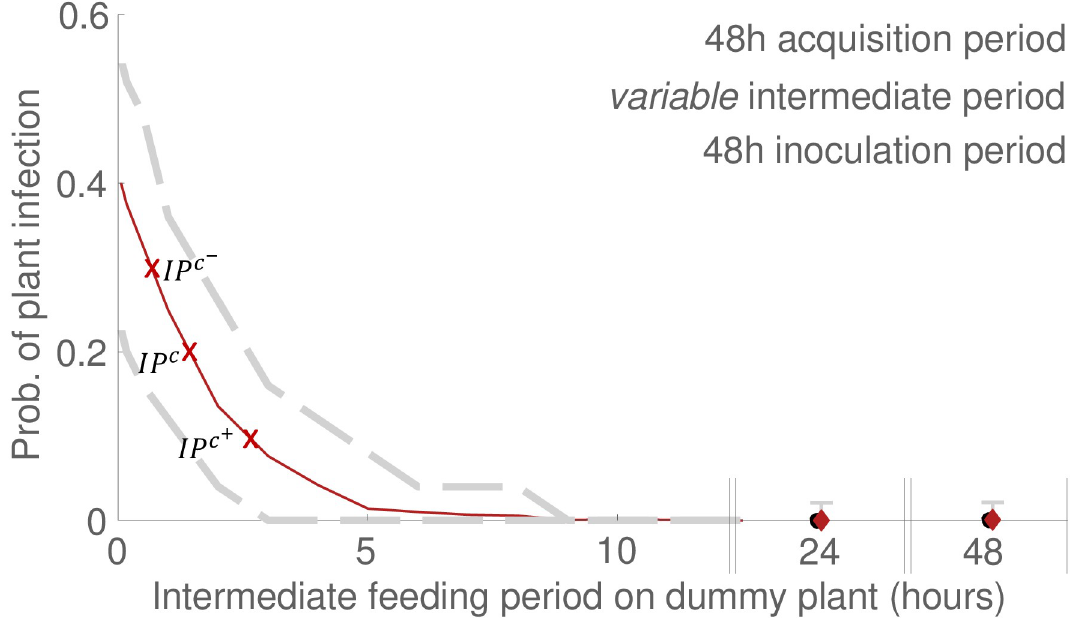
Fig 5. An empirical test of epidemiological parameter estimates for CBSV: Dynamic simulations vs. experimental data for variable intermediate feeding periods. An additional experiment is described in Maruthi et al . in which insects were given access to an intermediate feeding period on a dummy plant [1] (see methods section). Black circles indicate datapoints from [1]. Ruby curves/ diamonds indicate the mean of simulations. Gray dashed curves/gray intervals indicate the 2.5th and 97.5th percentiles of simulations. Red crosses mark the intermediate period at which transmission success was 50% of that of no intermediate period ( IP c : 0.197 prob. of plant infection after 1.45 h intermediate period), 25% of that of no intermediate period ( IP c þ : 0.099 prob. of plant infection after 2.58 h intermediate period), and 75% of that of no intermediate period ( IP c (cid:0) : 0.296 prob. of plant infection after 0.6 h intermediate period)(c. f. prob. of plant infection was 0.394 when the intermediate period was 0 h ). For details of the simulation procedure see caption of Fig 2. Note that Maruthi et al . considered intermediate periods of 24 and 48 hours (appended portions of x-axis), see S6 Appendix. At these points the gray vertical simulated intervals consist only of the zero value for the probability of plant